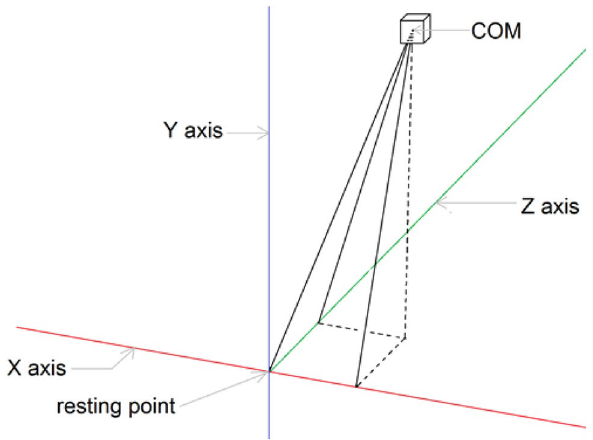
Figure 2. Determining the coordinates of the projection of the COM (a simplified 3D